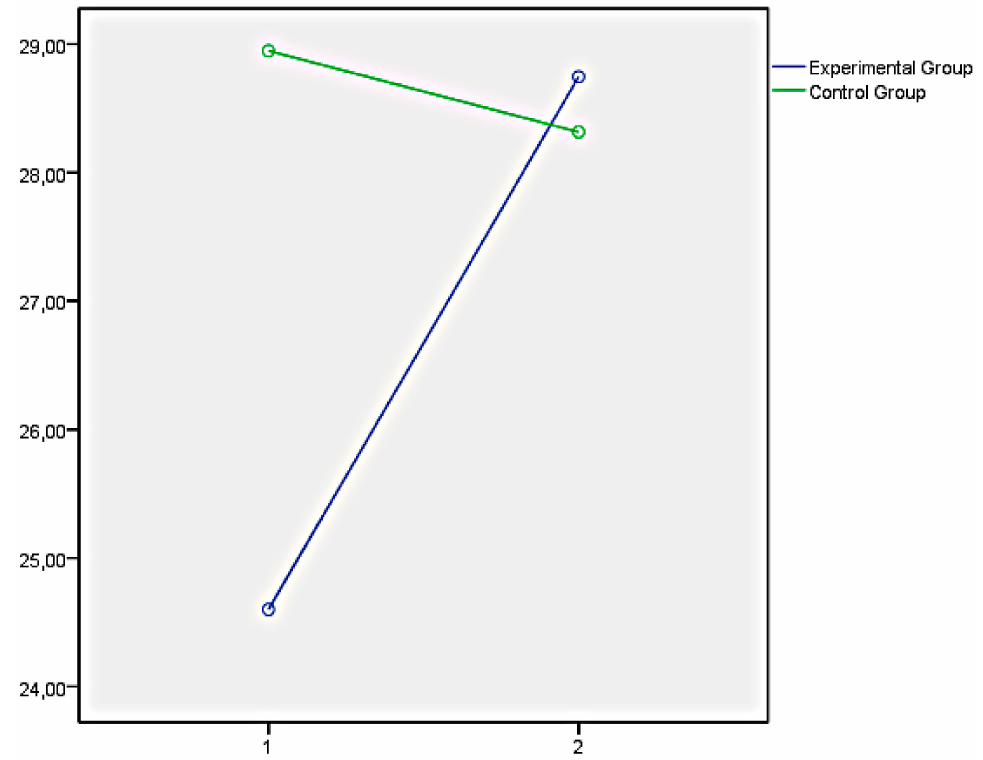
Figure 2. Attention after the educational intervention measured with Trait Meta-Mood